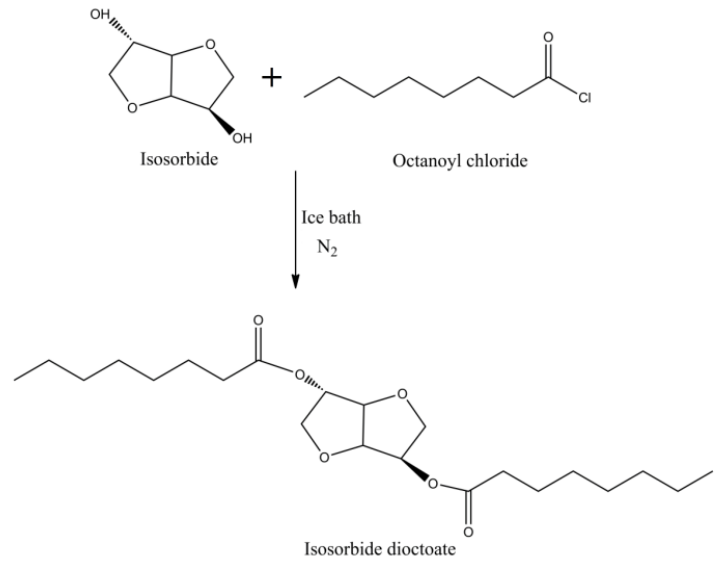
Figure 20. Synthesis of isosorbide dioctoate.